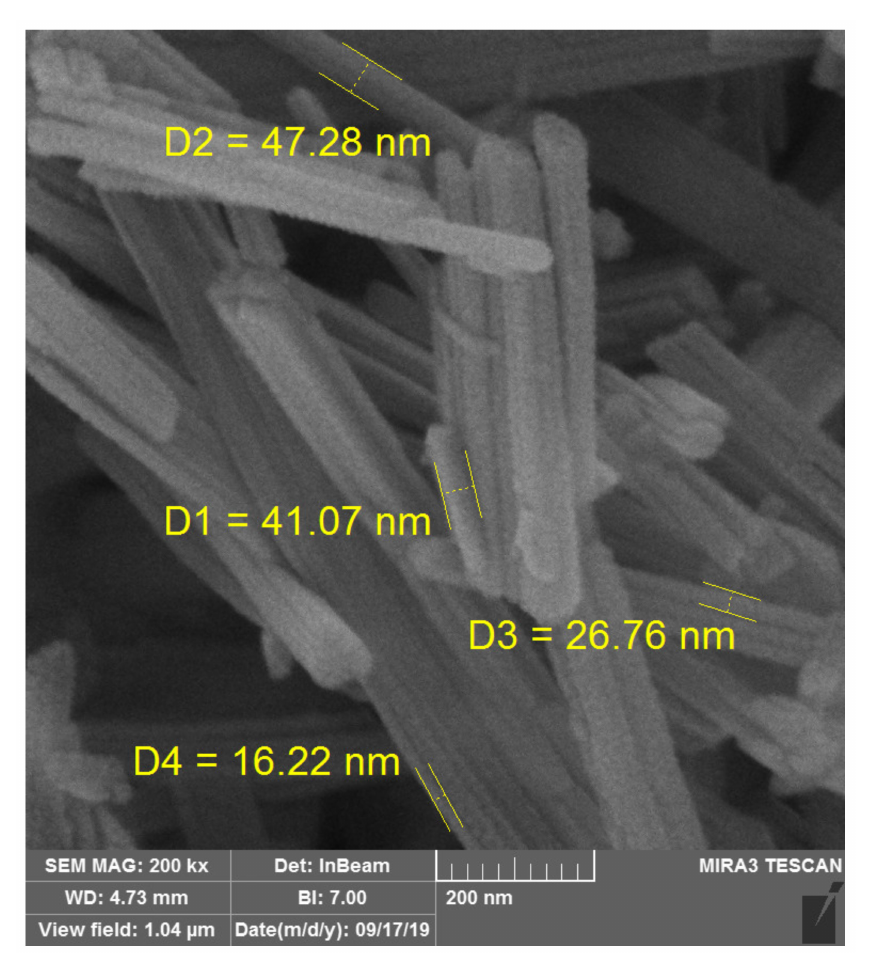
Figure 5. SEM image showing sepiolite